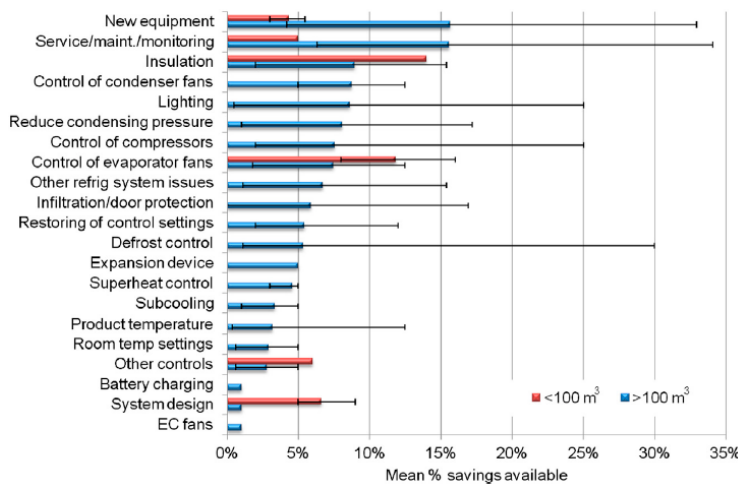
Figure 2. Examples of energy savings in refrigeration systems [6].